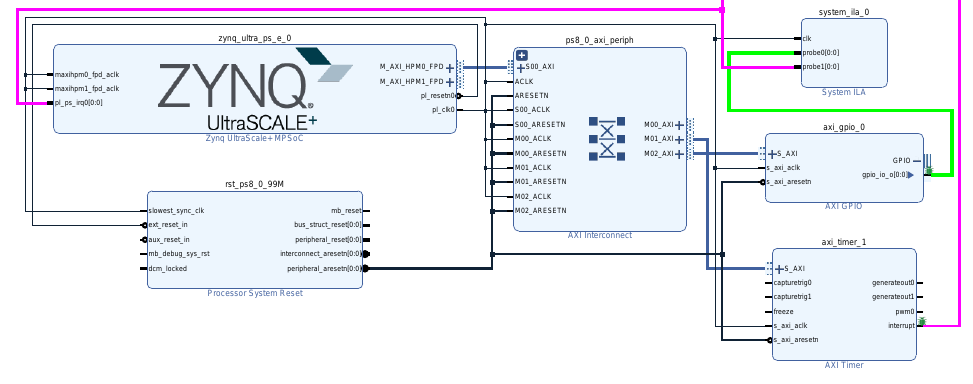
Figure 9. Hardware IP block design in